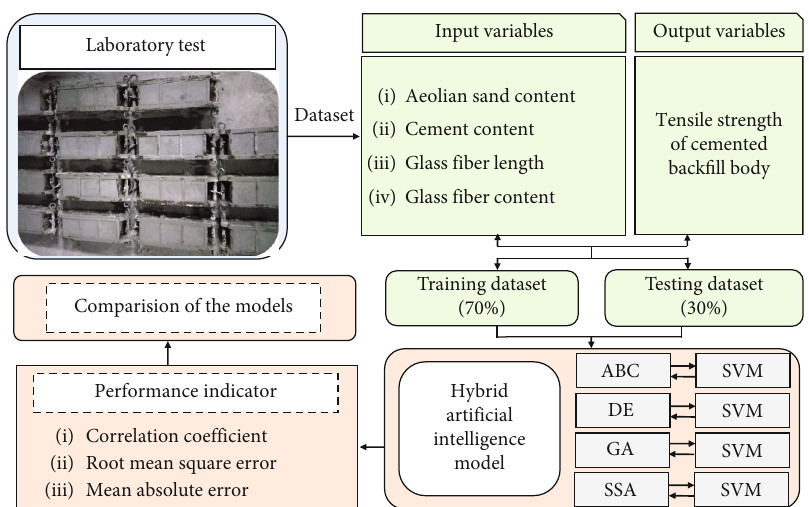
Figure 4: Overall analysis